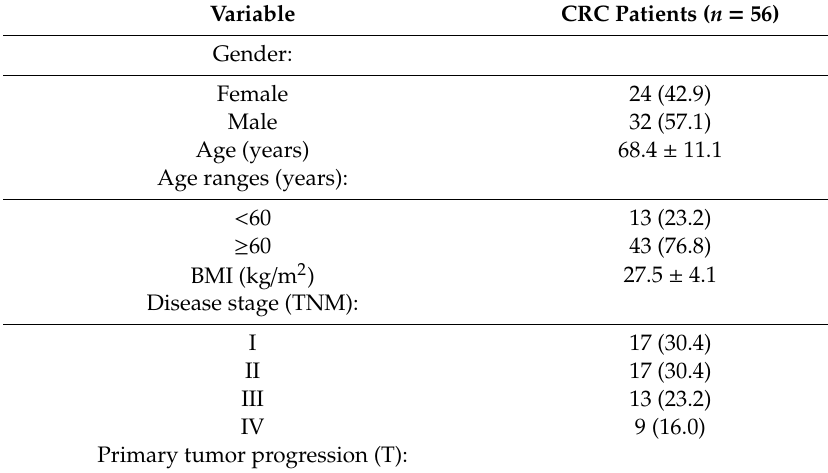
Table 1. Distribution of demographical, clinical and pathological variables in patients with colorectal cancer (CRC). Data are presented as number of observations (percent of tested population) or mean ±